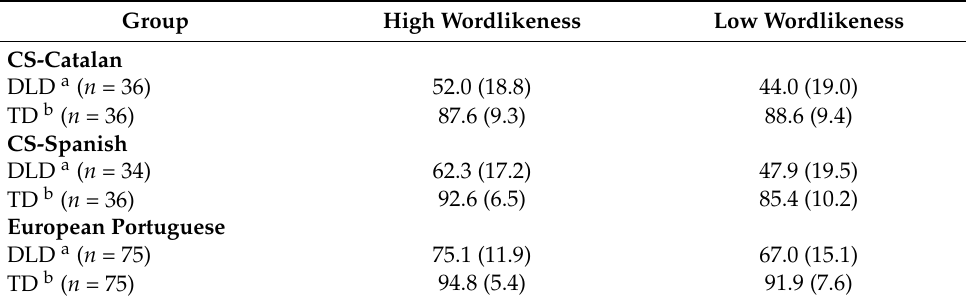
Table 5. Means and standard deviations on the NRT for percentage of words correct (PWC) for high and low wordlikeness for the Catalan and Spanish versions of the NRT for the Catalan–Spanish (CS) and European Portuguese (EP) children with developmental language disorder (DLD) and typically developing (TD)